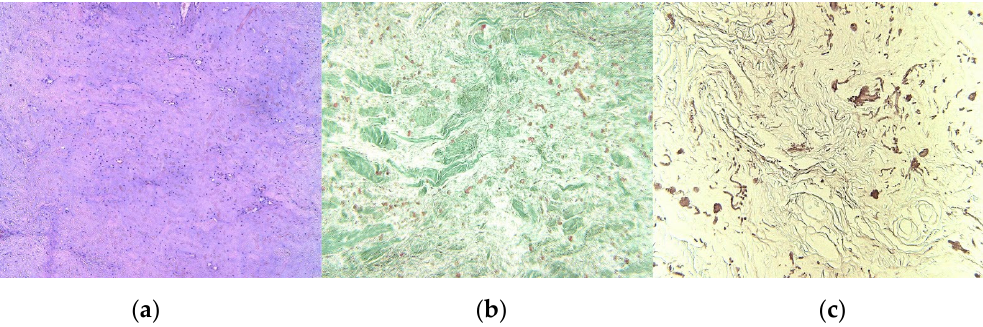
Figure 4. ( a ) Admixture of eosinophilic collagen fibers and birefractive thick, coarse, and sometimes globular distributed elastic fibers, H&E stain, original magnification (OM) × 10; ( b ) Acidophilic green different sized bundles of collagen fibers and a smaller quantity of red elastic fibers, Masson’s trichrome stain, OM × 10; ( c ) Red-brownish elastic fibers, with different sizes and aspects, orcein staining, OM × 10. (Nikon SMZ25 with Nikon’s Perfect Zoom System).